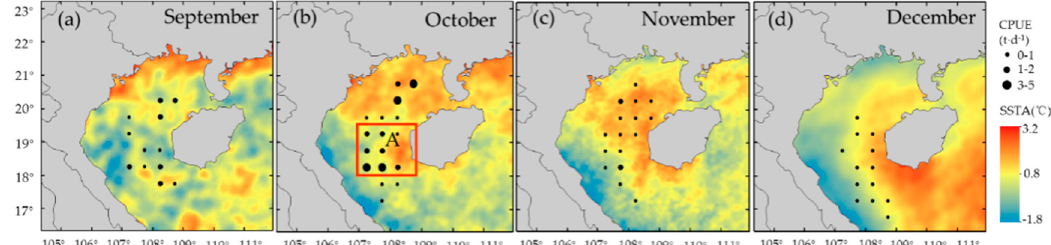
Figure 6. Spatial distribution of SST anomaly (SSTA) in Beibu Gulf: ( a ) SSTA in September, ( b ) SSTA in October, ( c ) SSTA in November and ( d ) SSTA in December.